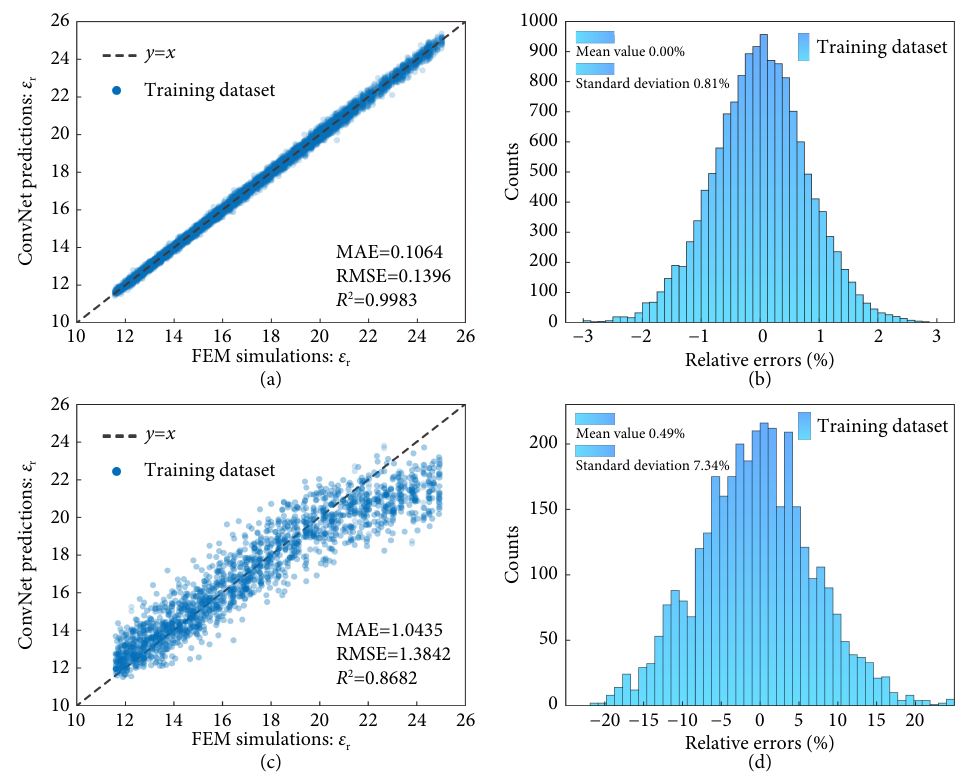
Fig. 6 The performance of homemade ConvNet model for prediction of the relative permittivity of BT/PVDF nanocomposites on the (a) training data and (c) testing data and the corresponding relative errors distribution on the (b) training data and (d) testing data.